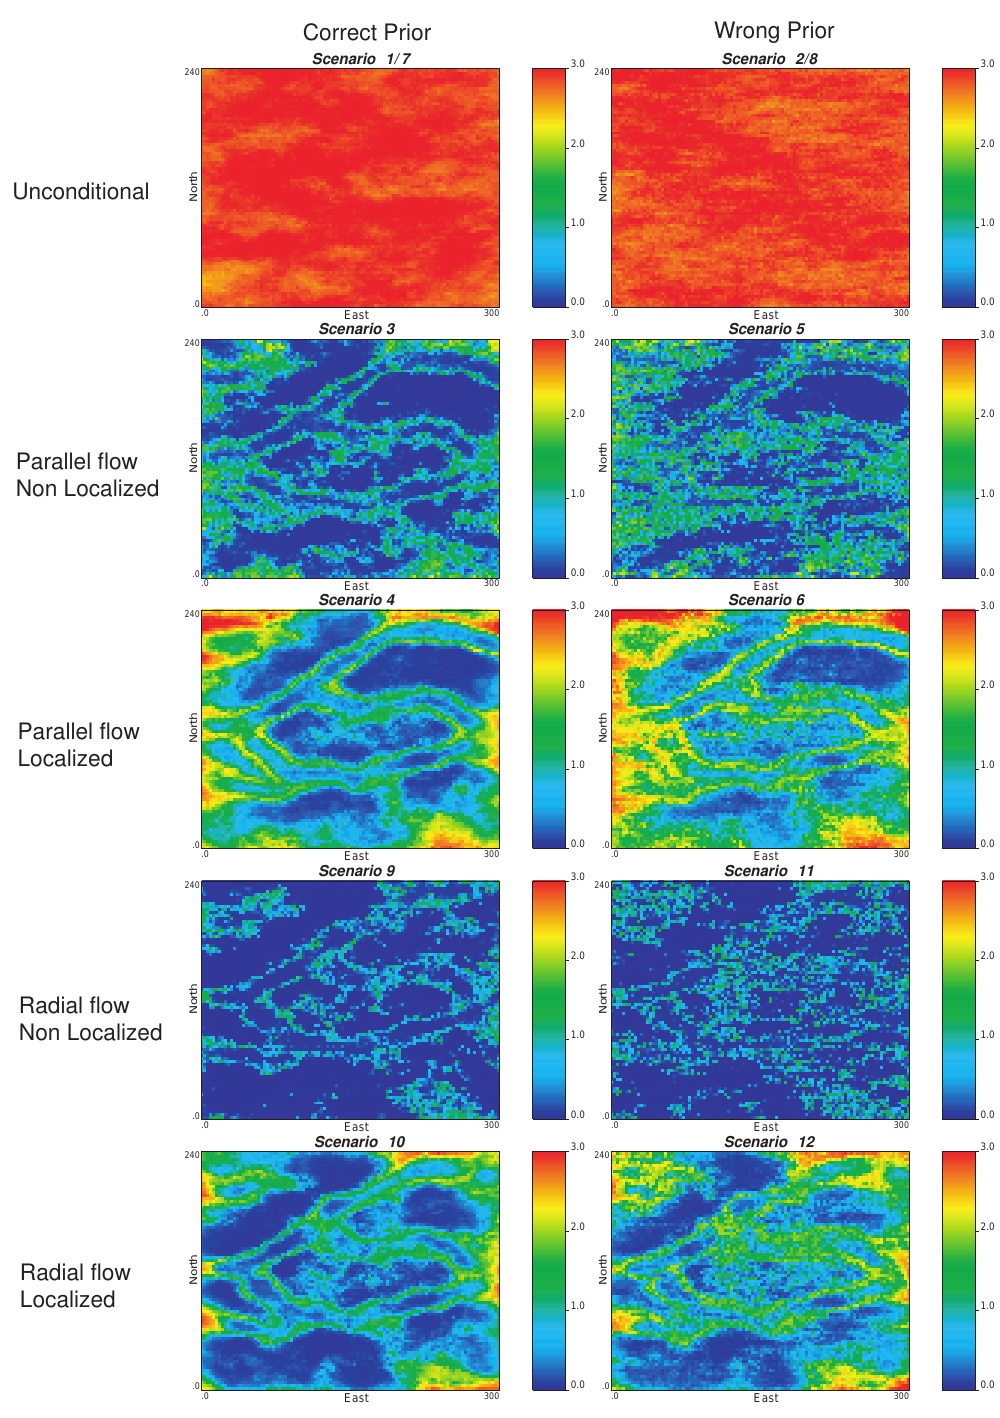
Fig. 6. Ensemble variance logconductivity fields at time step nT =60 for the different scenarios. 37